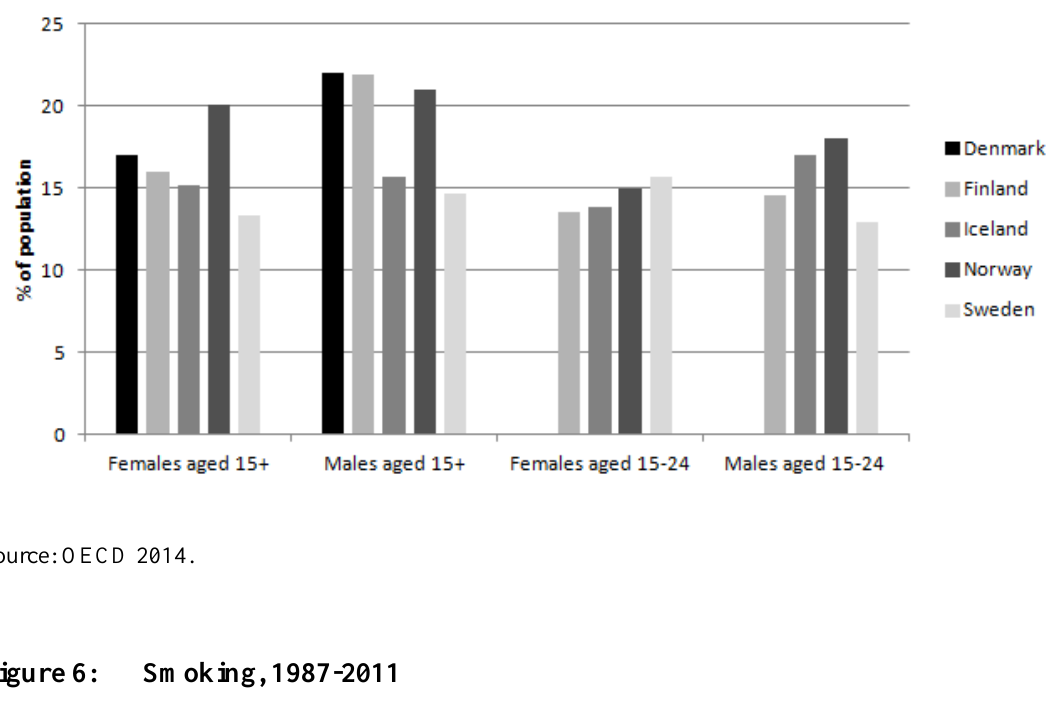
Figure 5: Daily smokers by gender and age group, 2009